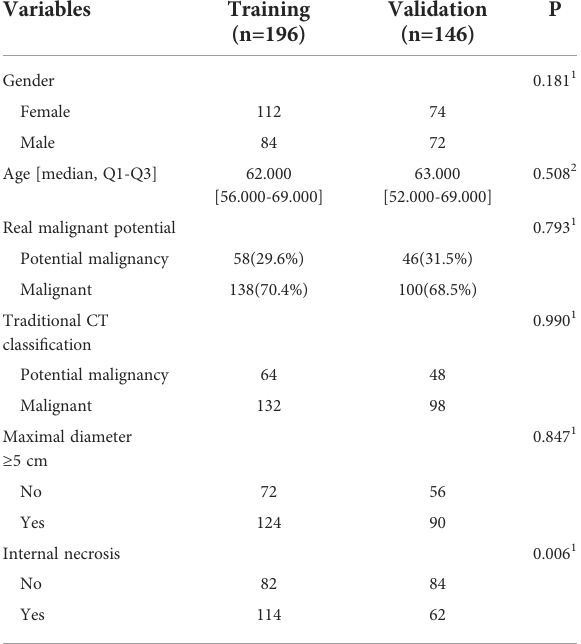
TABLE 2 Clinical data of the training and validation groups.